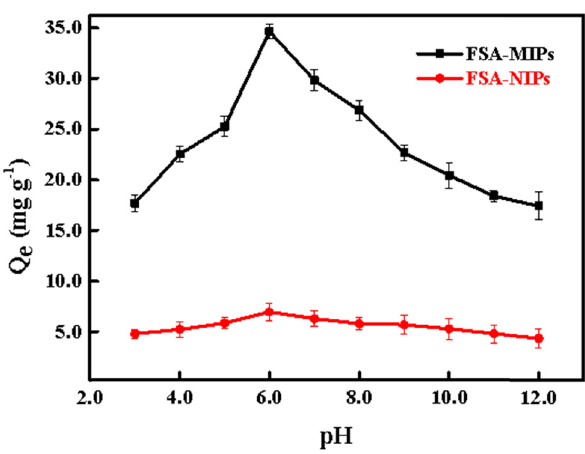
Figure A5: The linear fi tting curves of Scatchard adsorption model of 4 - MMC onto FSA - MIPs at di ff erent temperatures.